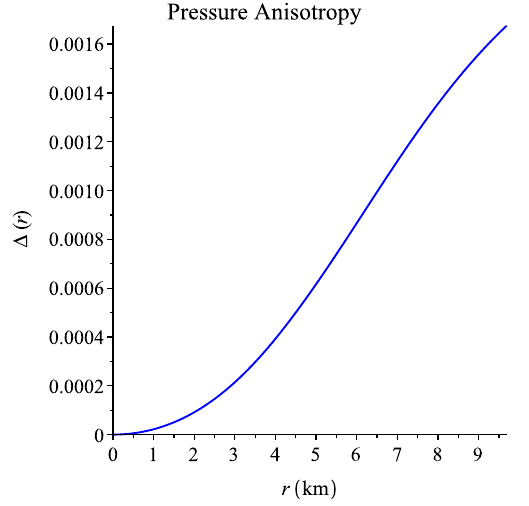
Fig. 1 Plot of pressure anisotropy (cid:10) (Eq. (3.41)) for a compact object like PSR J1614-2230 using the model III with p = 2, q = 1 and the values of parameters a = 0 . 0695 , b = 0 . 0001 , and c = 0 . 001. For details see Table 2